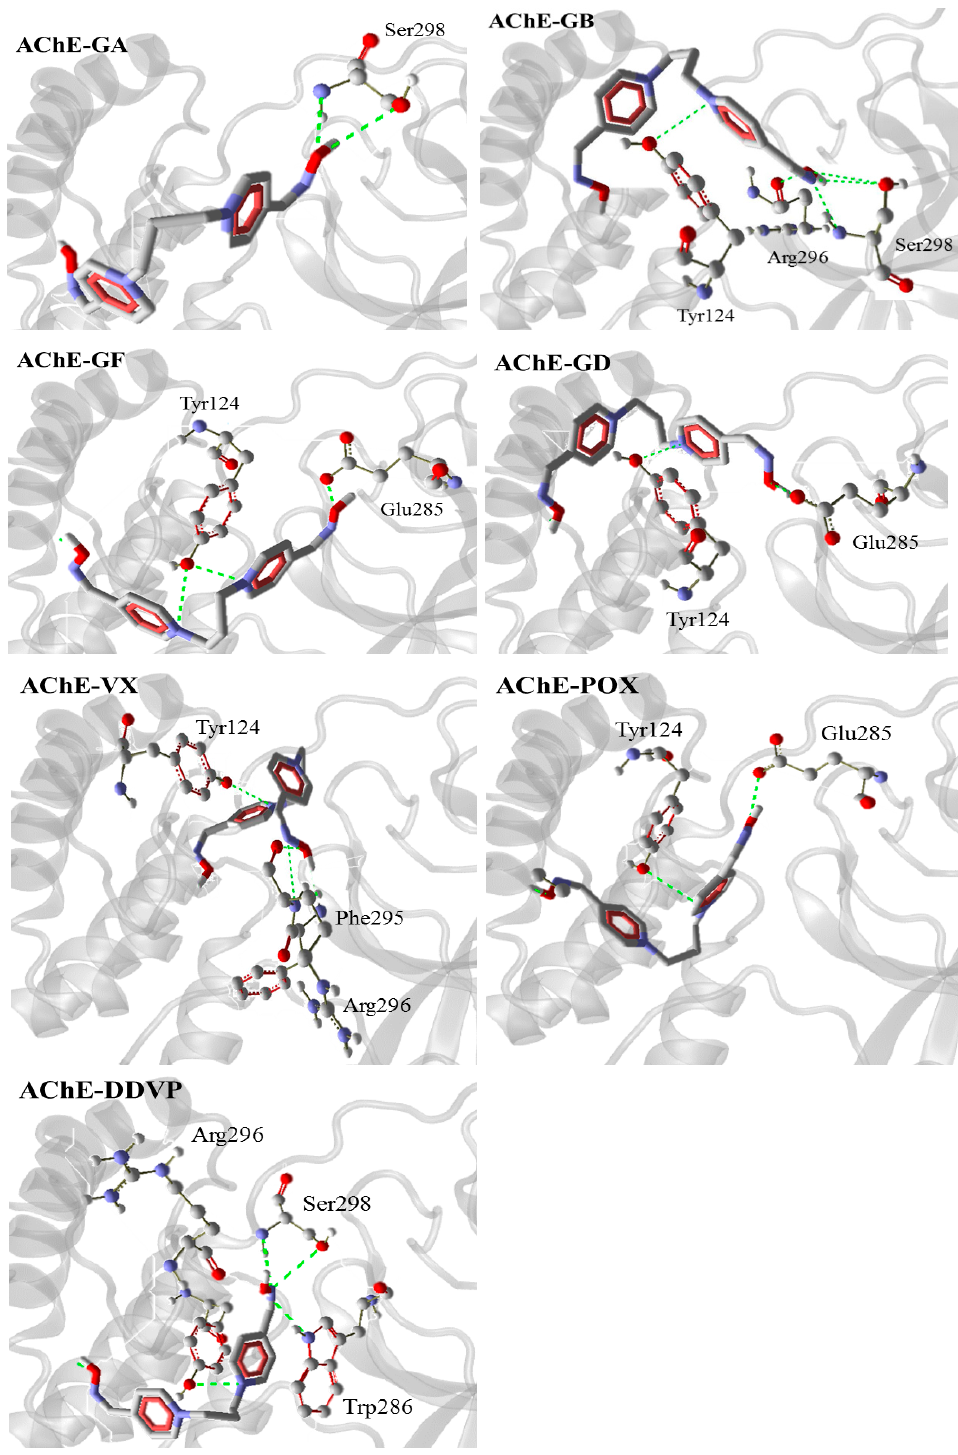
Figure 4. Representation of the hydrogen bonds performed by trimedoxime in the site.